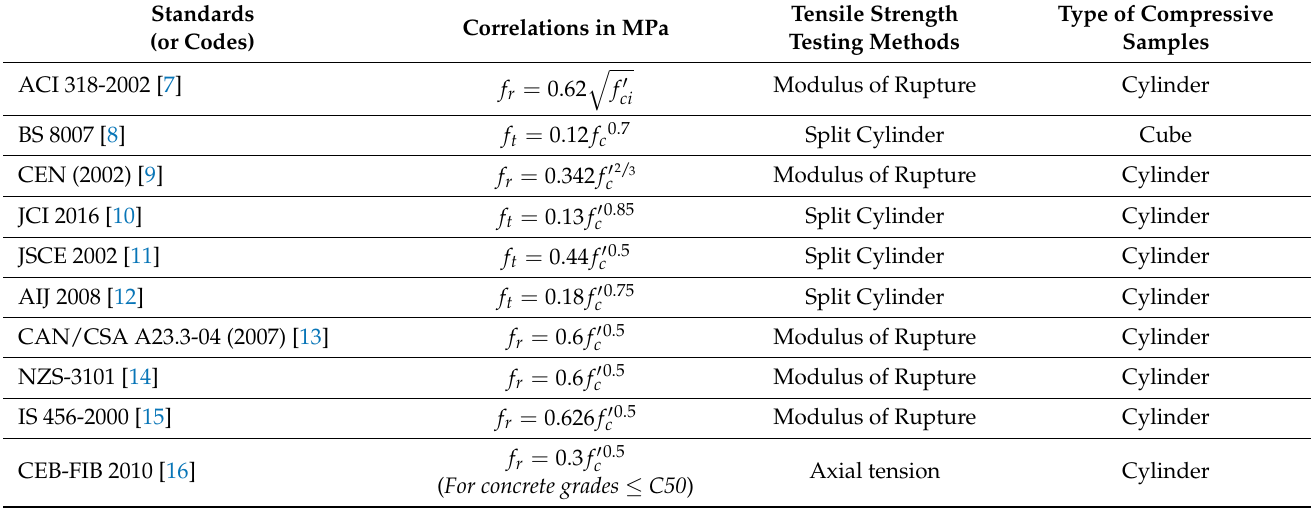
Table 1. Tensile Strength and Compressive Strength Empirical Correlations in